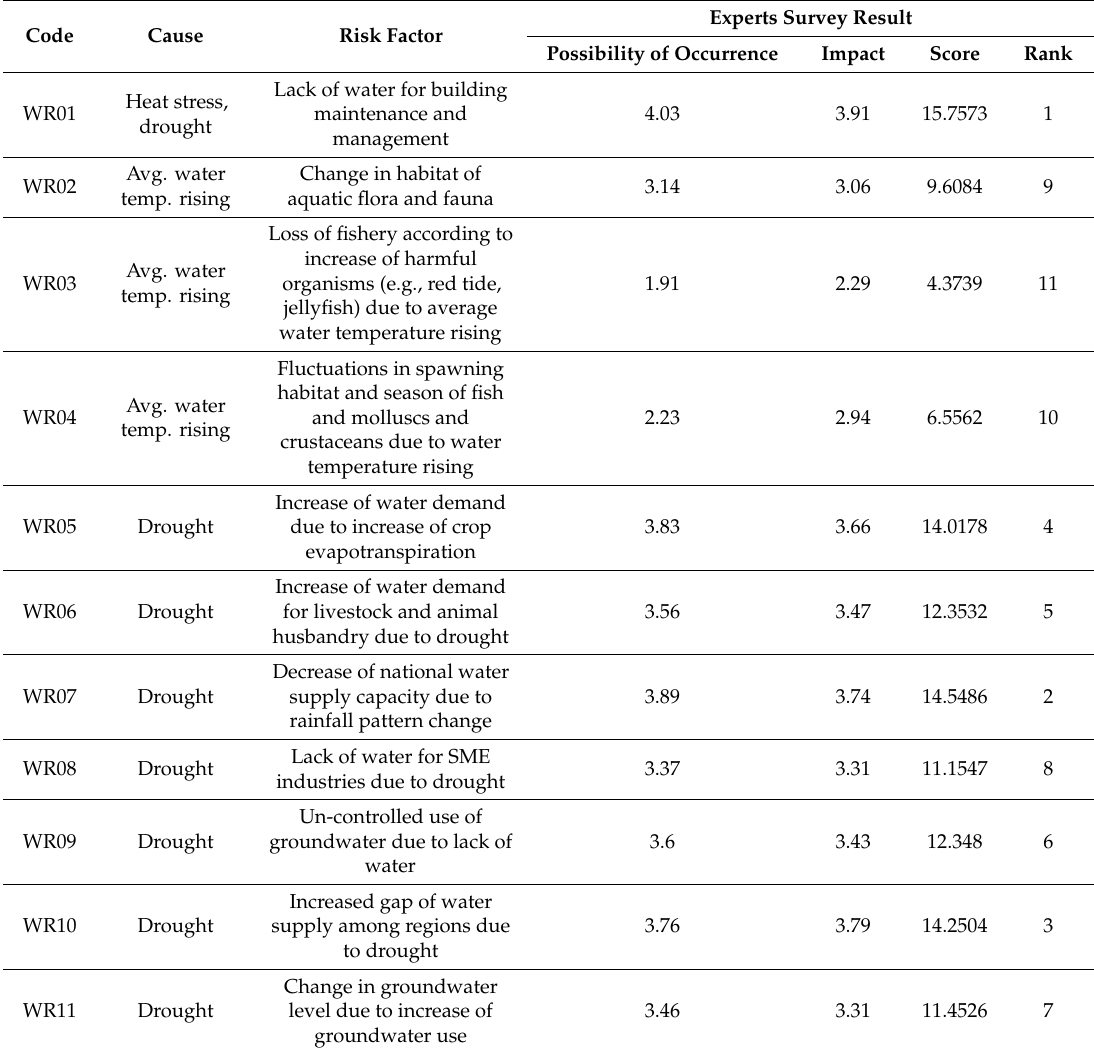
Table A4. WR risk factors and assessment result of Kurunegala.